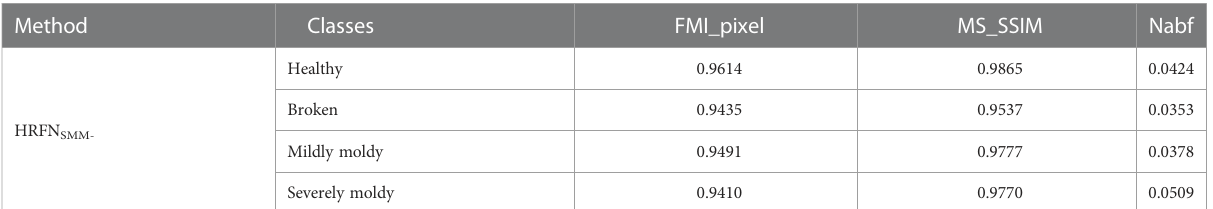
TABLE 4 Quantitative results of fusion HSI and RGB using HRFN SMM-.